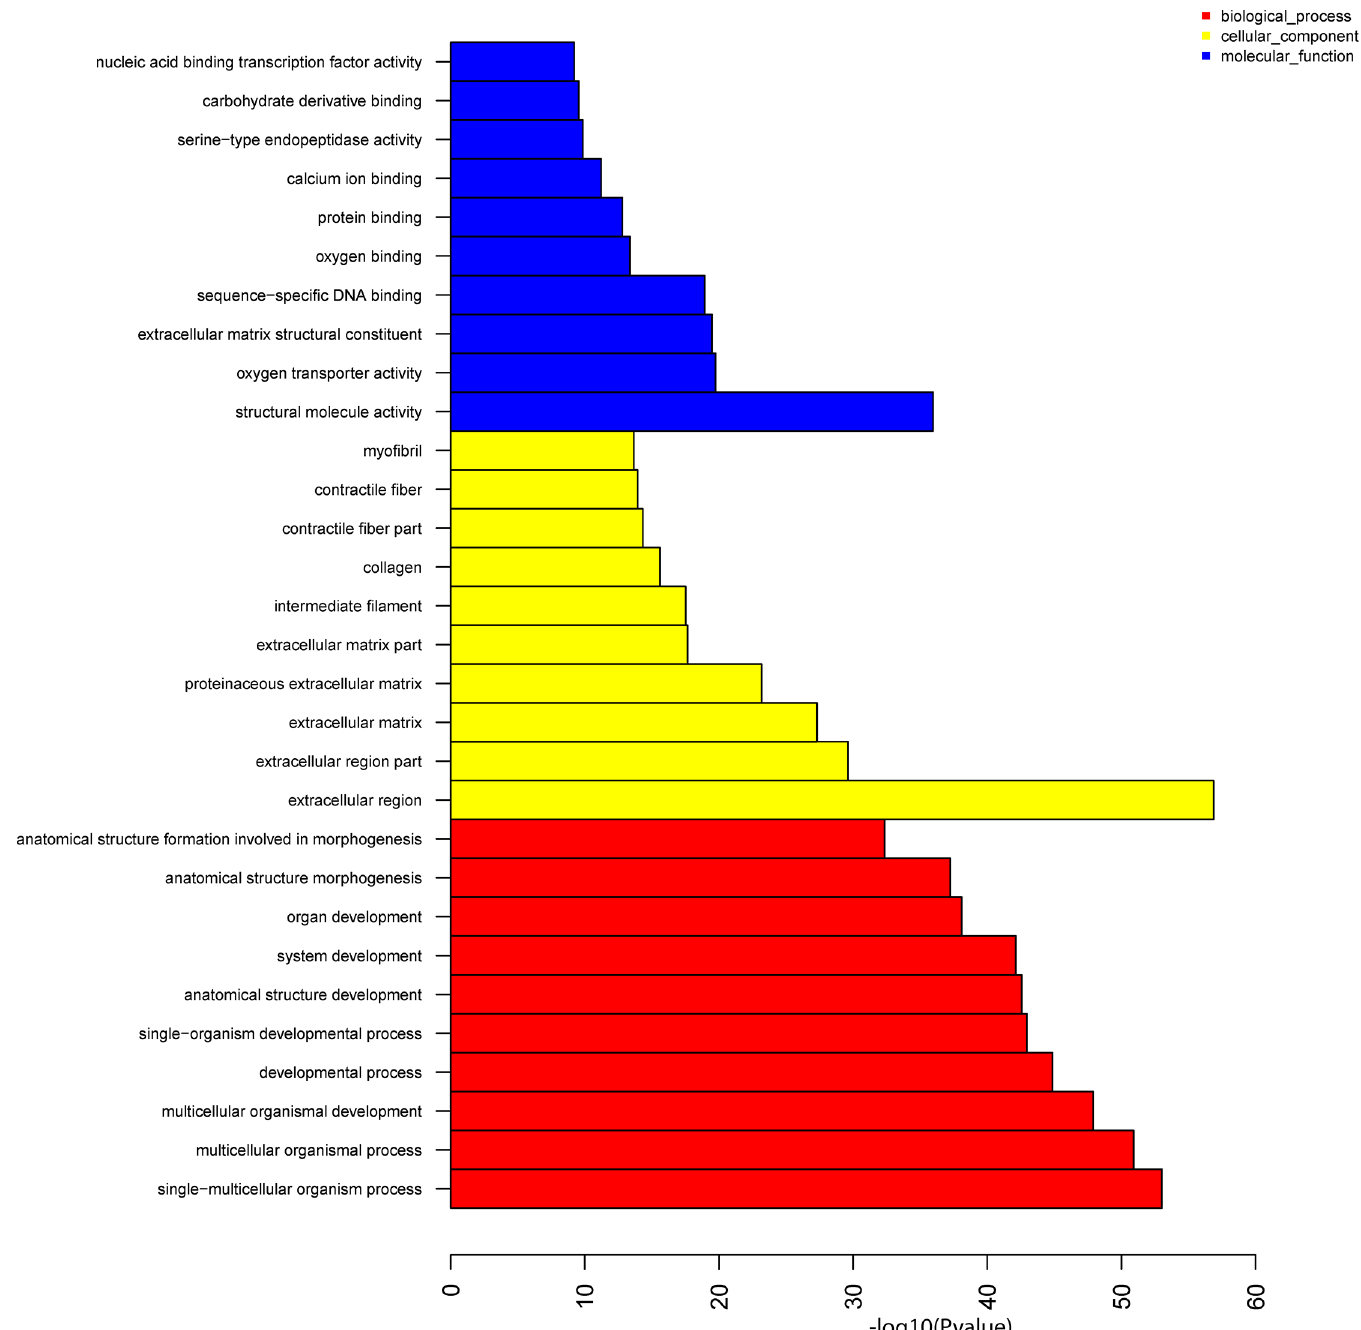
Fig 1. Histogram of the most significantly enriched GO terms obtained from the GO enrichment analysis of all DEGs. The significance of each GO term was estimated based on the p-value (p-value < 0.05) and the FDRs (FDR (cid:5) 1.82E-01); blue color denotes “ molecular functions ” , yellow represents the “ cellular component ” and red the “ biological process ”